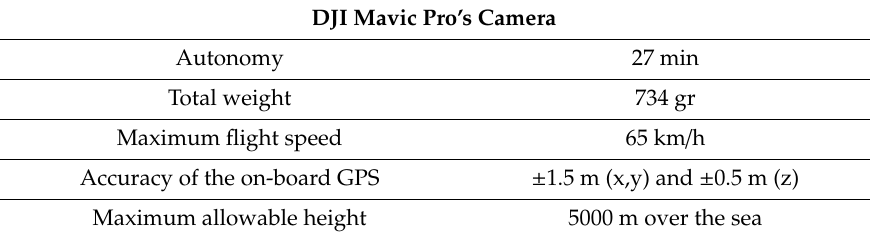
Table 4. Technical specifications of the drone used.